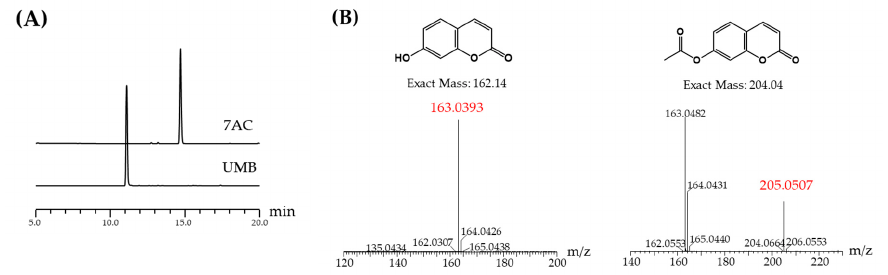
Figure 1. ( A ) HPLC analysis of umbelliferone (UMB), 7-acetoxycoumarin (7AC); ( B ) structure and mass analysis of UMB and